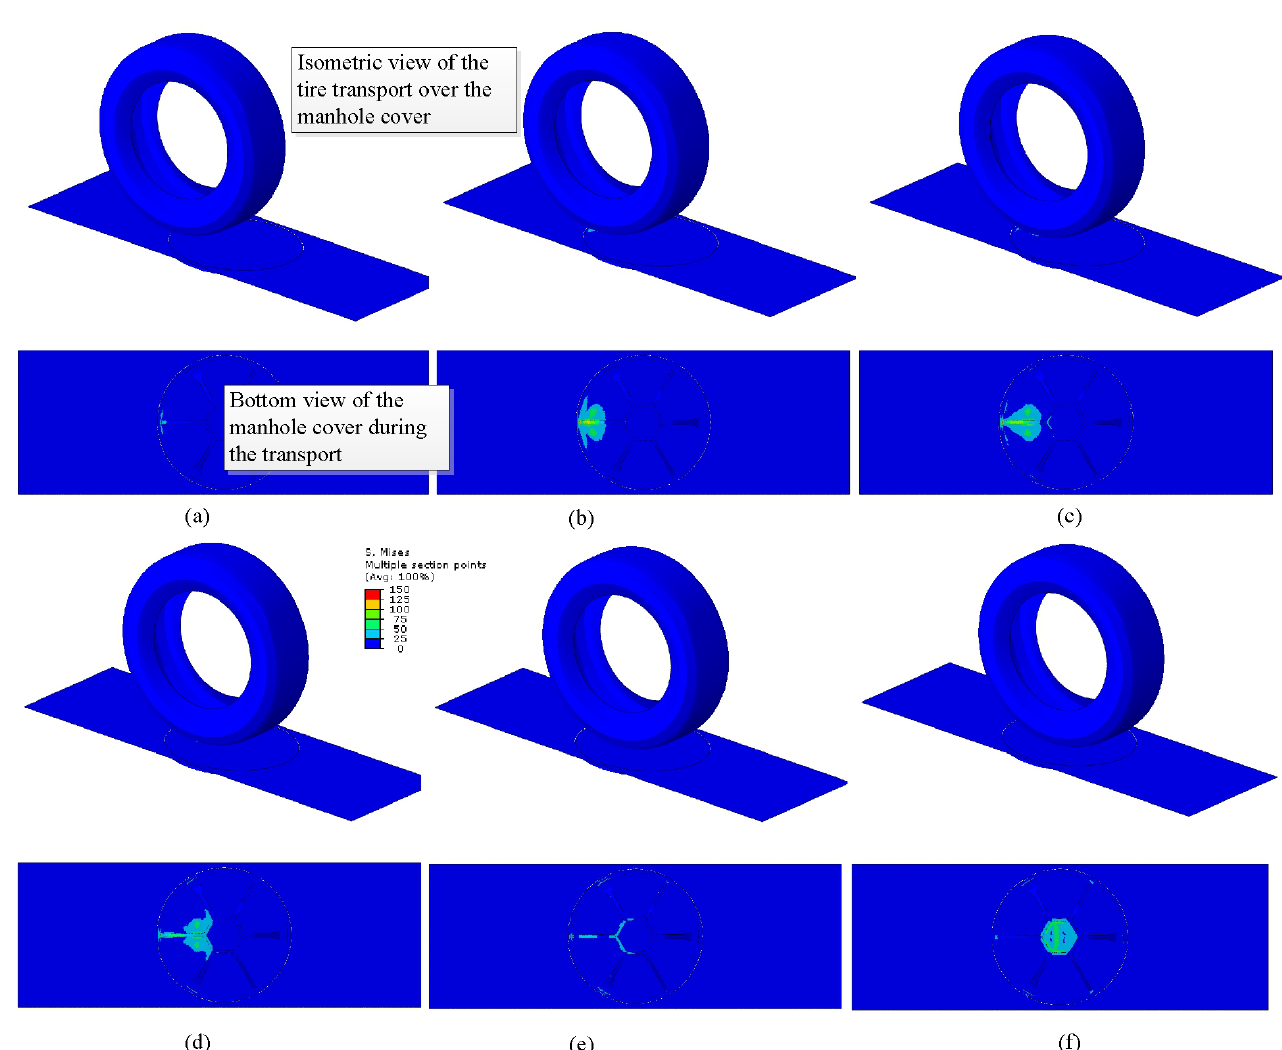
Figure 5. Simulation results (von Mises stress) during the application of the load between the initial contact (Position ( a )) and the middle of the manhole cover (Position ( f )). Positions ( b – e ) show equidistant steps between the initial contact and the middle of the manhole